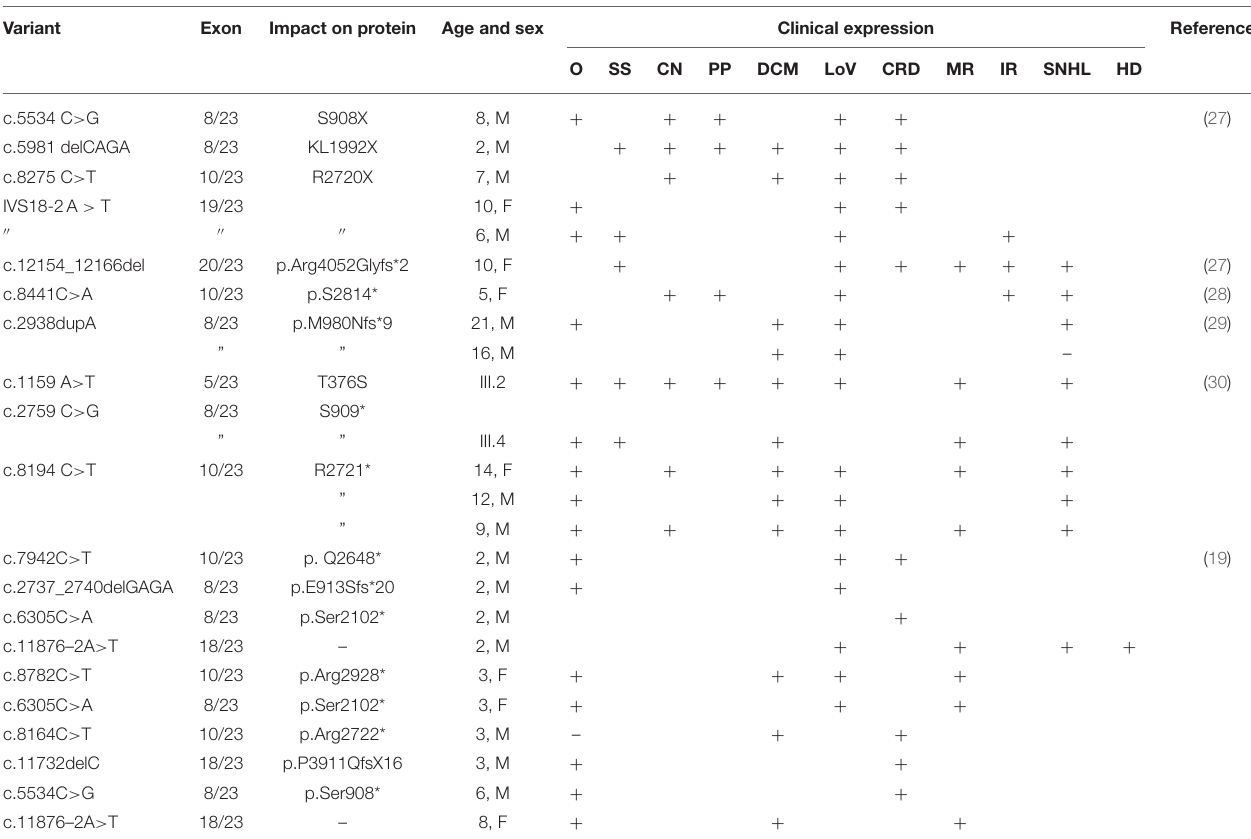
TABLE 2 | Summary of genetic mutation vs. clinical features observed in Saudi Alström